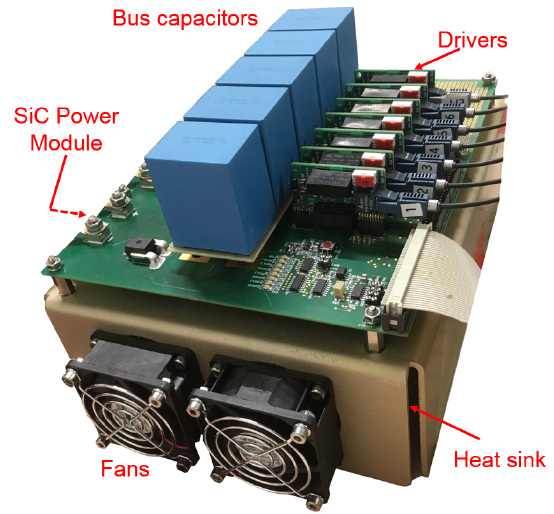
Figure 10. Three-phase inverter using SiC power module verify loss calculation in a 15-kVA/540-V application.